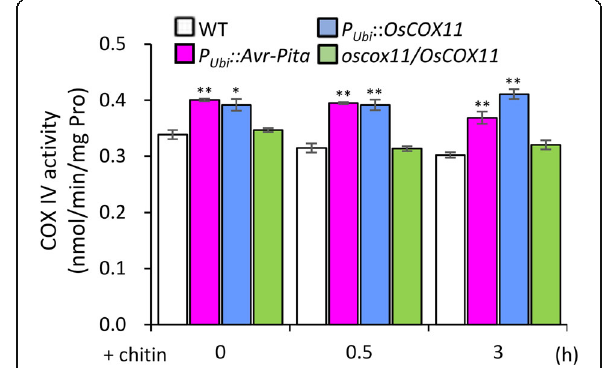
Fig. 6 Avr-Pita promotes cytochrome c oxidase activity. COX activity was measured in WT, P Ubi ::Avr-Pita , P Ubi ::OsCOX11 , and oscox11/